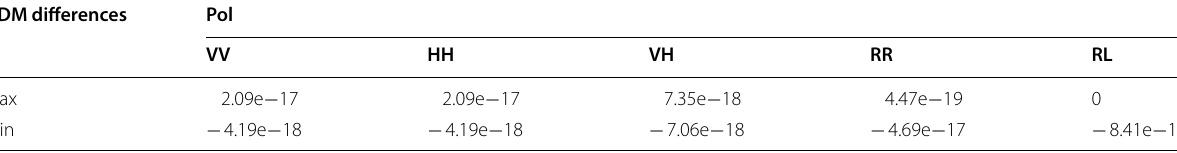
Table 5 Maximum and minimum DDM differences at linear and circular polarizations for different soil moisture